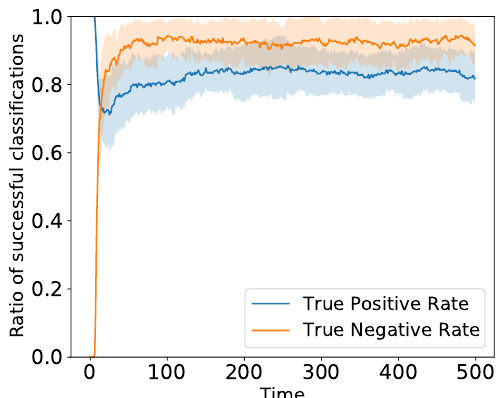
Figure 11. Temporal evolution of true positive and negative rates in the borderline identification experiment with 30 robots. Darker curves represent median TPR and TNR and contours of the shadow areas are the first and third quantiles, using a sample of size 50.